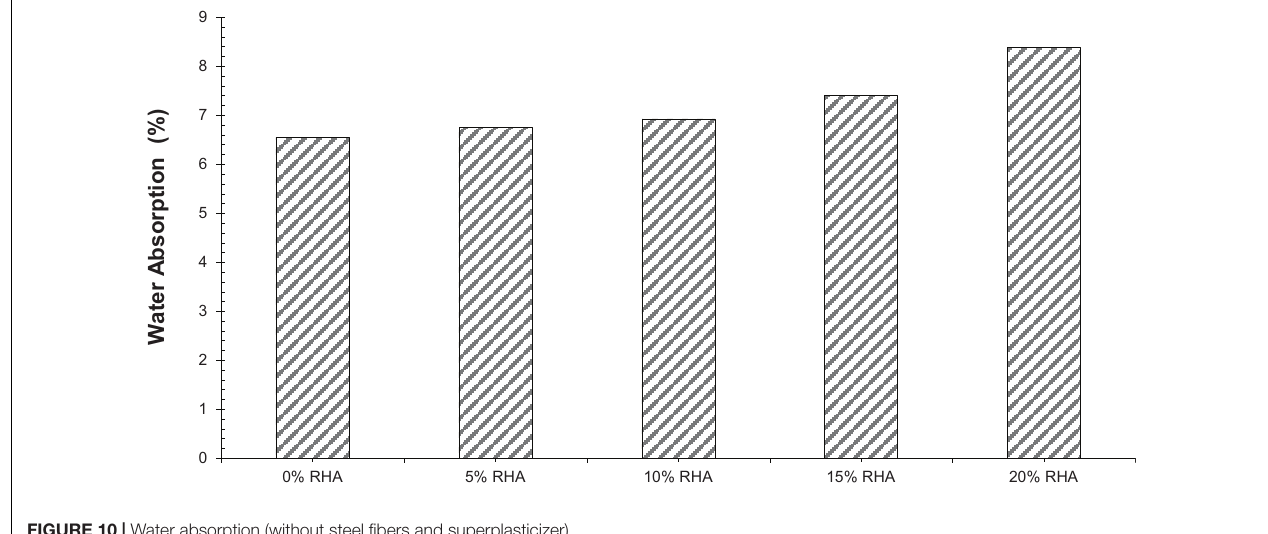
FIGURE 10 | Water absorption (without steel fibers and superplasticizer).